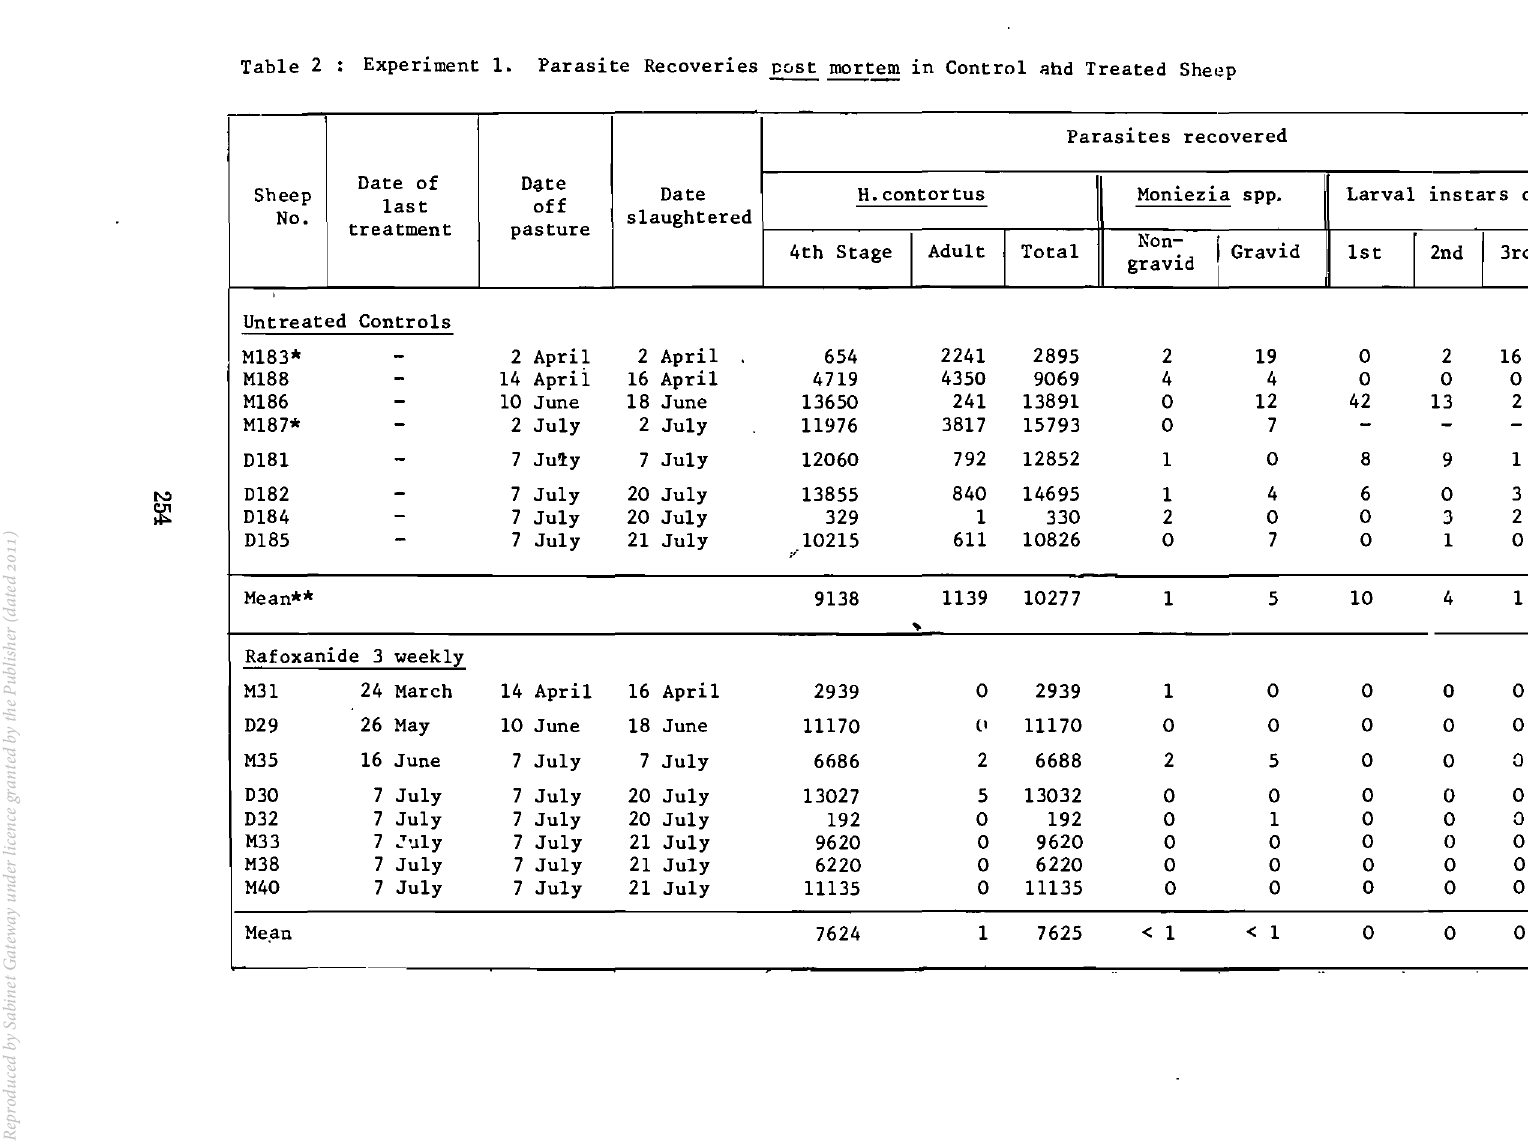
Table 2 Experiment